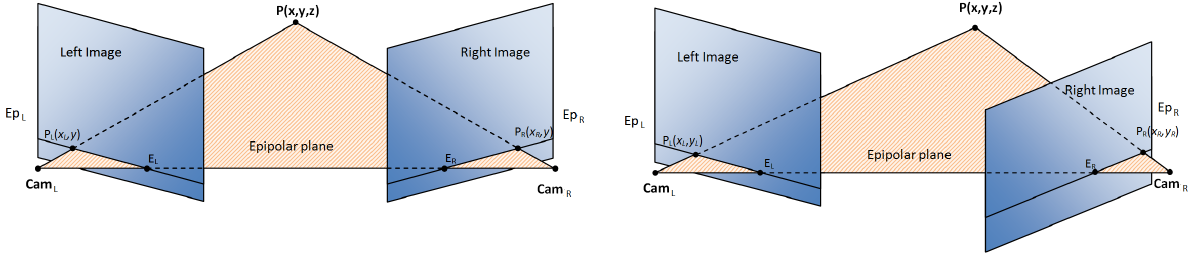
Figure 1. Epipolar geometry for a pair of cameras. Left : P corresponds to ( x ( x , y ) coordinates for the left and right image planes respectively. Right : The same P R point corresponds to different x and y coordinates on each image plane. Ep the epipolar lines, Cam the